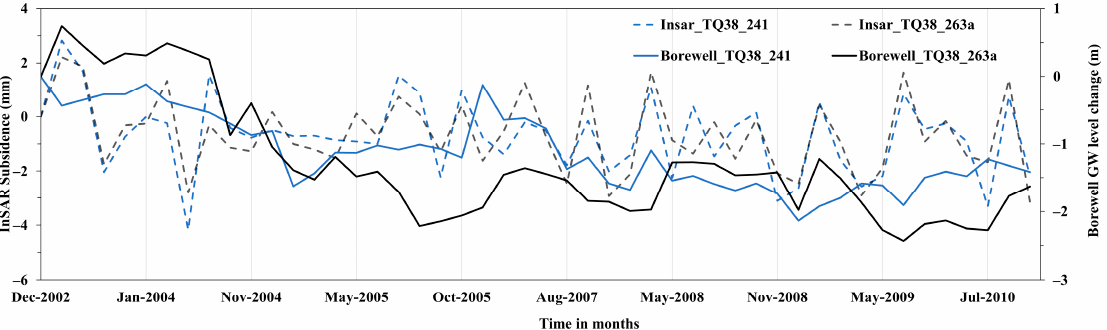
Figure11. Subsidenceandgroundwatertime-seriesforboreholesoneithersideofthenorthernboundary fault (i.e., TQ38_241 (45–47 Gresham Street) on the southern side and TQ38_263a (Victoria House, Southampton Row) on the northern